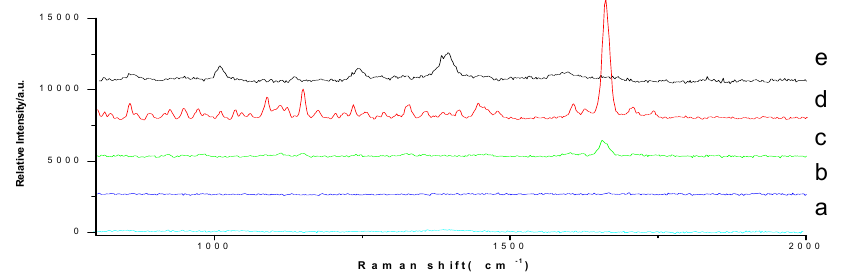
Figure 3. Raman spectra of prednisone acetate ( a : detected by TLC-SERS method without prednisone acetate, b : detected directly on TLC spot without prednisone acetate, c : detected by the TLC-SCRS method, d : detected directly on reference powder, and e : detected by the TLC-SERS method. The deposition amount is 10 μ g).